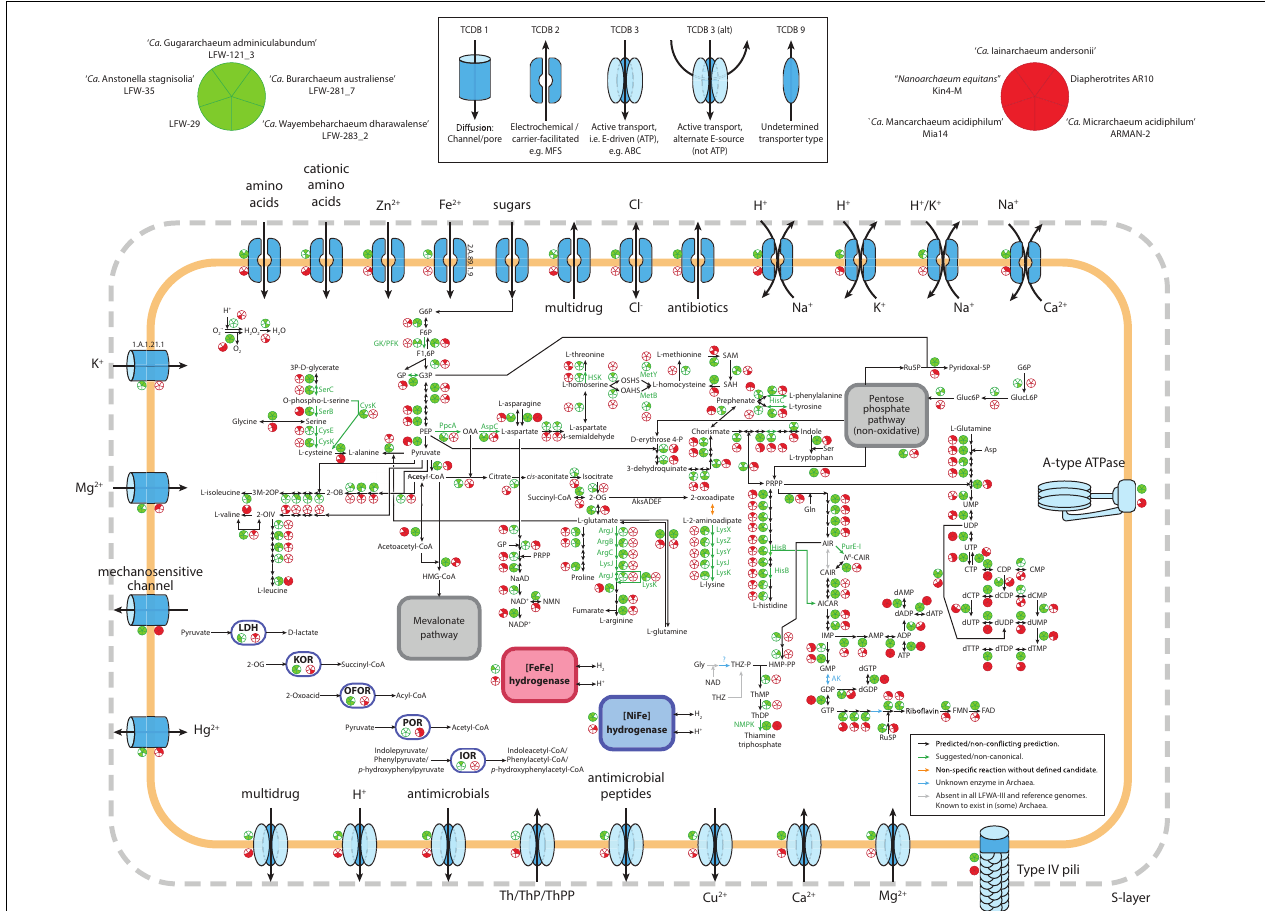
FIGURE 4 | . Comparative visualization of the metabolism of LFWA-III representative MAGs from this study (green circles) and selected reference DPANN genomes (red circled). Each sector in the indicative circles indicates the presence or absence of a key protein in the represented genome. Extracellular enzymes are not shown for simplicity. Abbreviations: 2-OG, 2-oxoglutarate; 2-OIV, 2-oxoisovalerate; AICAR, 5-amino-1-(5-phospho-D-ribosyl)imidazole-4-carboxamide; AIR, 5-amino-1-(5-phospho- β -D-ribosyl)imidazole; ARP, 5-amino-6-ribitylamino-2,4(1H,3H)-pyrimidinedione; CAIR, 5-amino-1-(5-phospho-D-ribosyl)imidazole-4-carboxylate; F1,6P, β -D-Fructose 1,6-bisphosphate; F6P, β -D-Fructose-6P; FAD, Flavin adenine dinucleotide; FMN, Flavin mononucleotide; G3P, Glyceraldehyde-3P; G6P, Glucose-6P; Gluc6P: D-gluconate 6-phosphate; GlucL6P: D-glucono-1,5-lactone 6-phosphate; GP, Glycerone-P; HMP-PP, 4-amino-5-hydroxymethyl-2-methylpyrimidine diphosphate; IOR: indolepyruvate:ferredoxin oxidoreductase; KOR: 2-oxoglutarate:ferredoxin oxidoreductase; LDH: D-lactate dehydrogenase (NAD + ); N5-CAIR, 5-(carboxyamino)imidazole ribonucleotide; NAD + , β -nicotinamide adenine dinucleotide; NADP + , β -nicotinamide adenine dinucleotide phosphate; NMN, β -nicotinamide D-ribonucleotide; OAA, Oxaloacetate; OAHS, O-acetyl-homoserine; OFOR: 2-oxoacid:ferredoxin oxidoreductase; OSHS, O-succinyl-homoserine; PEP, Phosphoenolpyruvate; POR: pyruvate:ferredoxin oxidoreductase; PRPP, 5-phospho- α -D-ribose 1-diphosphate; Ru5P, D-ribulose 5-phosphate; SAH, S-adenosyl-L-homocysteine; SAM, S-adenosyl-L-methionine; ThDP, Thiamine diphosphate; ThMP, Thiamine monophosphate; THZ, 4-methyl-5-( β -hydroxyethyl)thiazolium; THZ-P, 4-methyl-5-( β -hydroxyethyl)thiazolium phosphate.